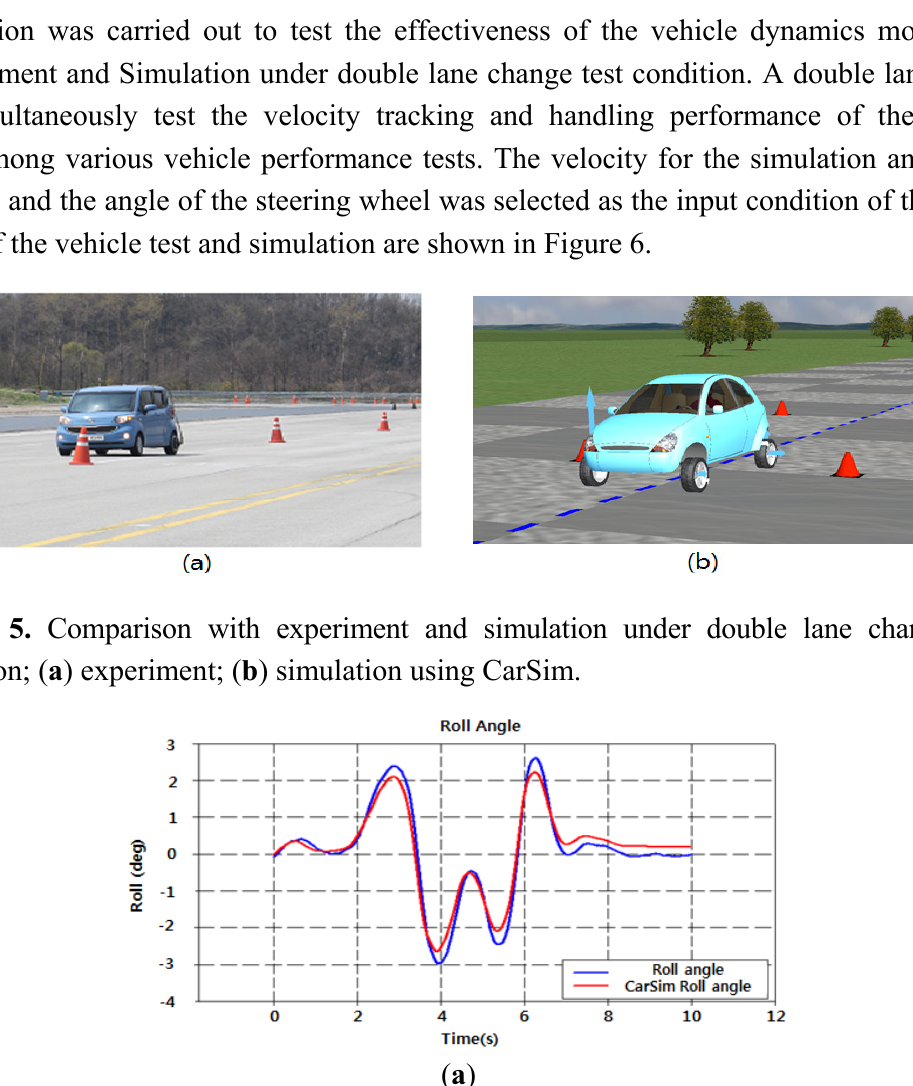
Figure 4. Co-simulation with MATLAB/Simulink and CarSim.